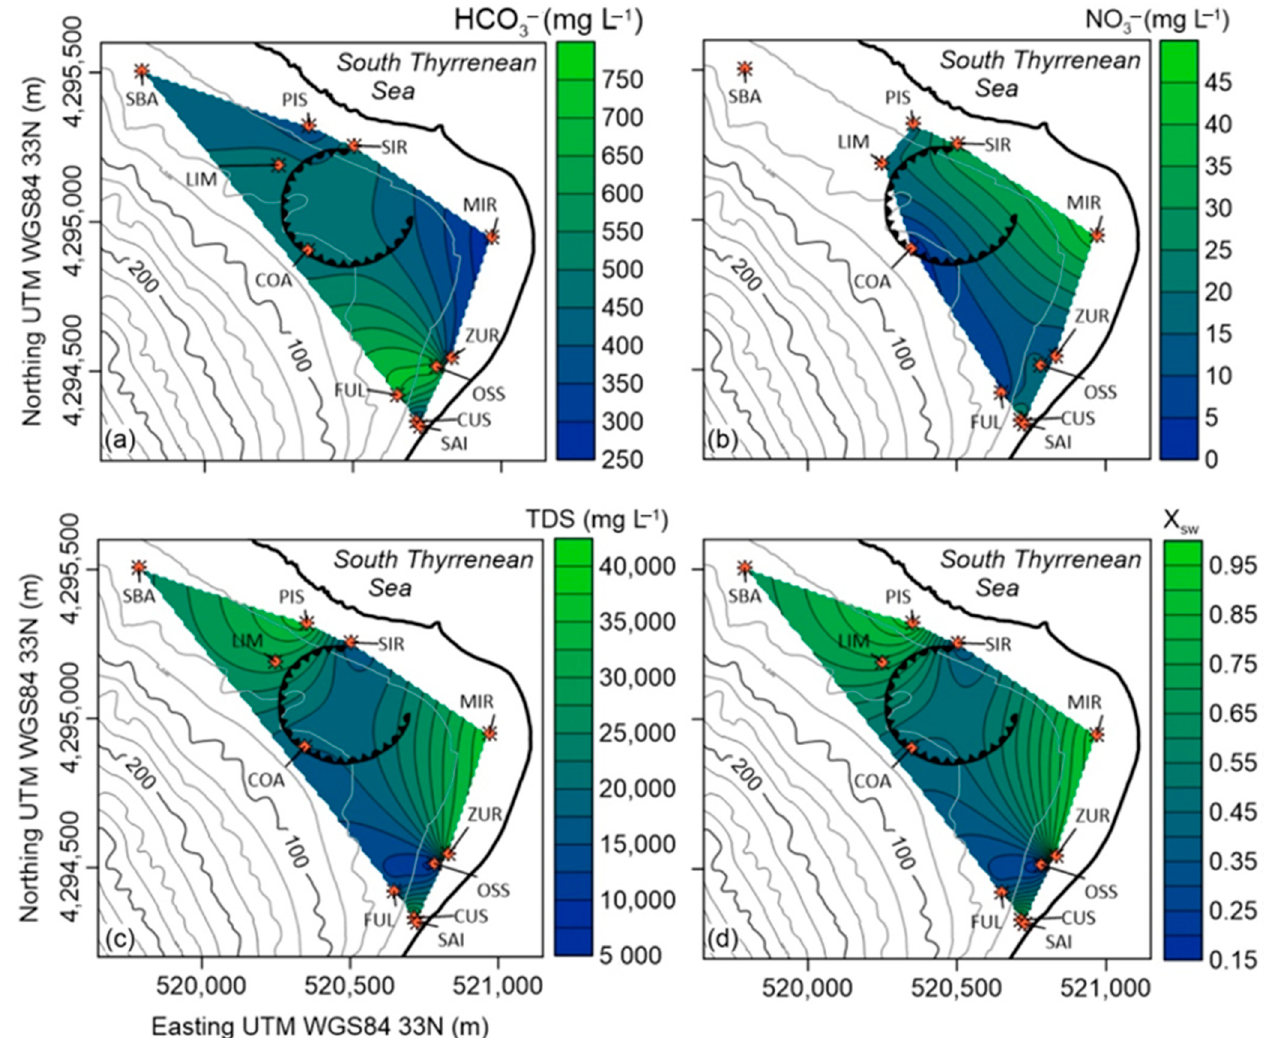
Figure 8. Concentration maps of ( a ) HCO 3 , ( b ) NO 3 , (c) TDS, and ( d ) the fraction of seawate r X SW